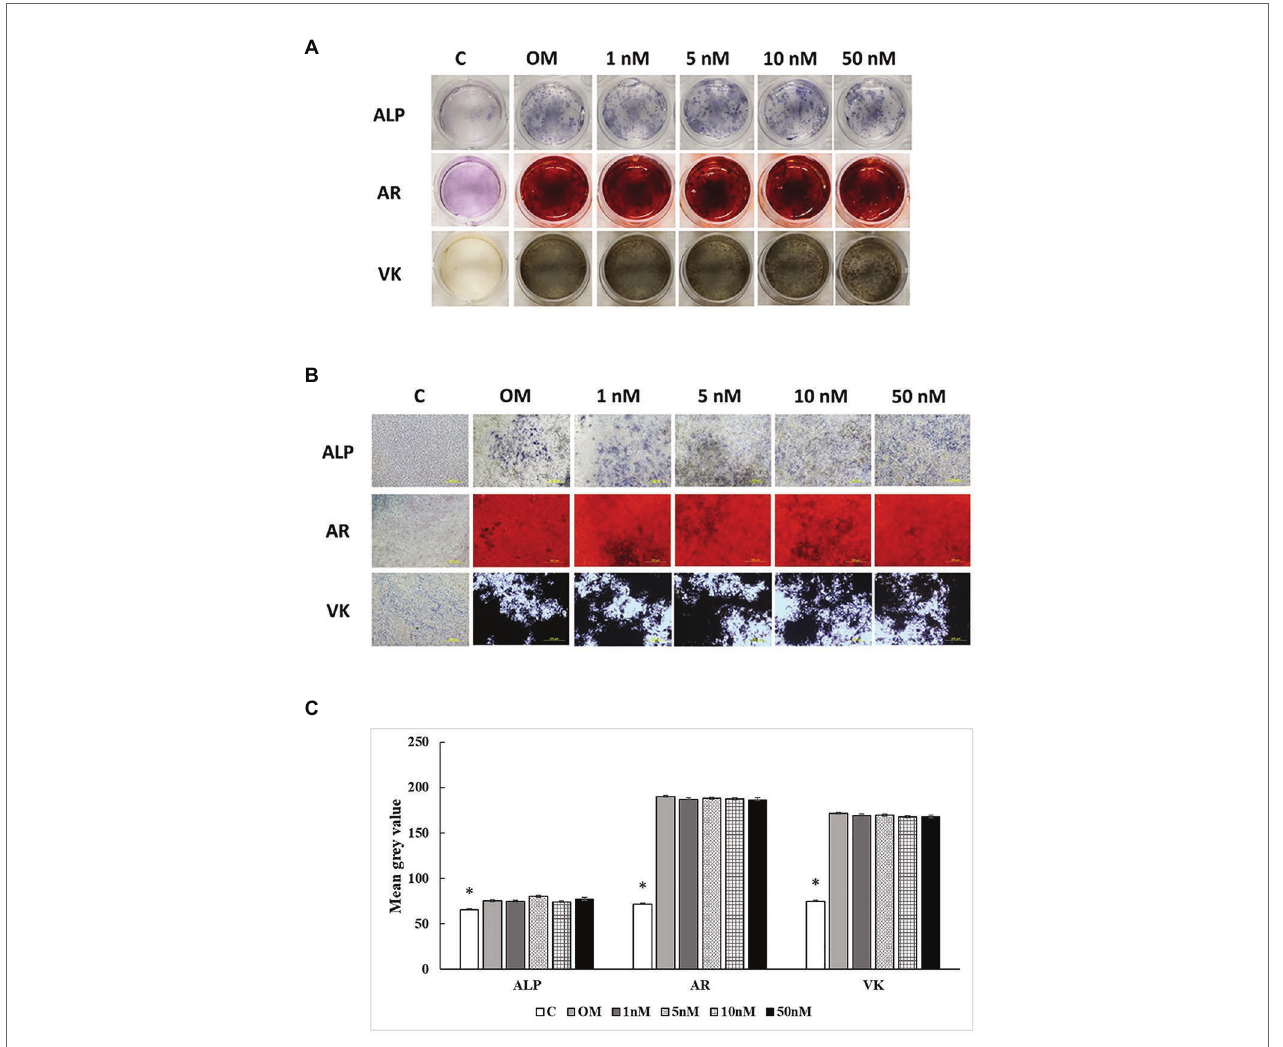
FIGURE 7 | Effects of 1,25OHD on chicken osteoblasts ALP activity and mineralization at 21 days. In each picture, the first row: ALP (Alkaline Phosphatase); the second row: AR (Alizarin Red stains the deposited minerals); and the third row: VK (Von Kossa stains for the deposited minerals). (A) Pictures were taken by DSRL camera, with same exposure setting across all the treatment. (B) The picture was taken under the microscope at 40x. The bar indicated 200 μ m. (C) The pictures (40x) were invert and converted to 8-bit gray scale using Image J software (1.48v version, U. S. National Institutes of Health, Bethesda, MD, United States). The mean gray value (0.16 mm 2 area) was measured. The values were presented as mean gray value. The higher value represents darker staining (Value means ± SEM, three replicates/treatment; * means significant difference compared to OM; ALP: p = 0.0447; AR: p < 0.0001; VK: p <